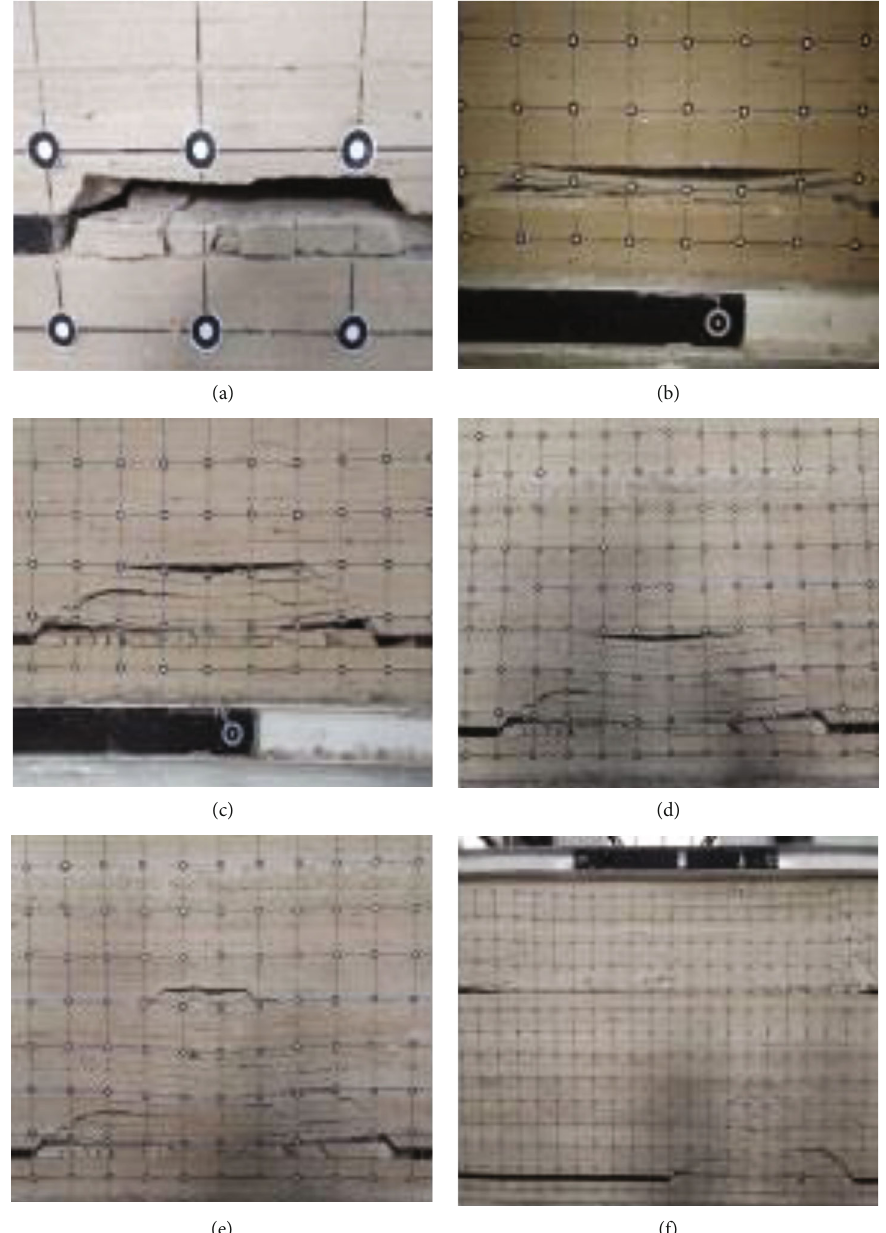
Figure 10: Caving and fracture development of surrounding rock in the J coal seam as the working face is pushed to (a) 42m, (b) 68 m, (c) 82m, (d) 92m, (e) 100 m (bureau), and (f) 100m